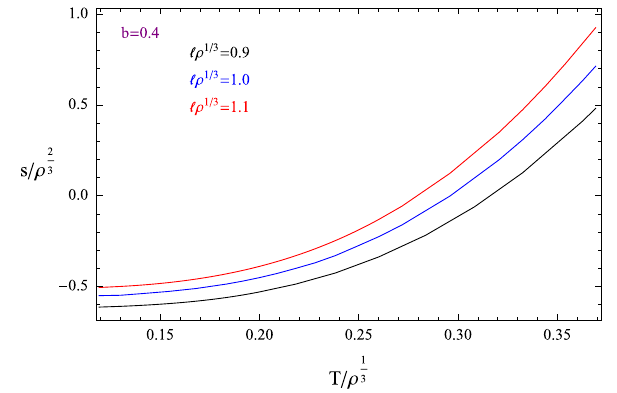
Fig. 5 The entanglement entropy of the operator (cid:2) O − (cid:3) with respect to the temperature T for various widths (cid:14) as b = 0 . 4. The red line is √ ρ = 1 . 1, the blue line is for (cid:14) for (cid:14) √ (cid:14) ρ = 0 .